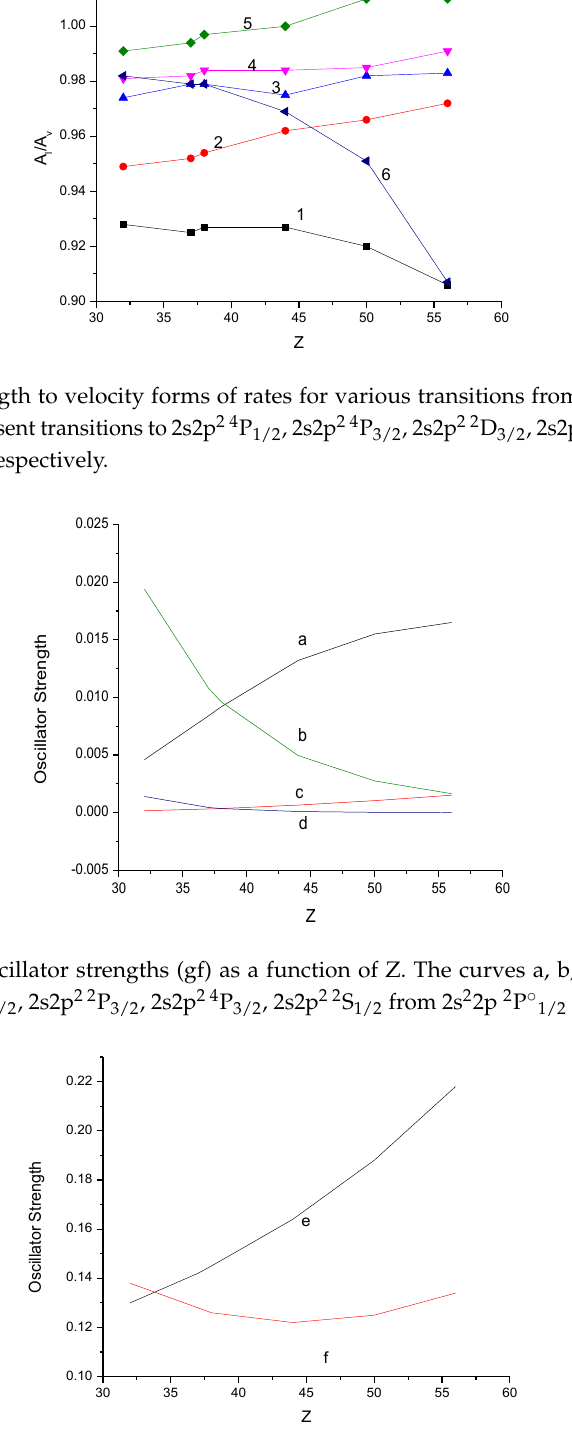
Figure 4. Weighted oscillator strengths (gf) as a function of Z. The curves e, and f correspond to transitions to 2s2p 2 2 D 3/2 , and 2s2p 2 2 P 1/2 from 2s 2 2p 2 P° 1/2 state, respectively.